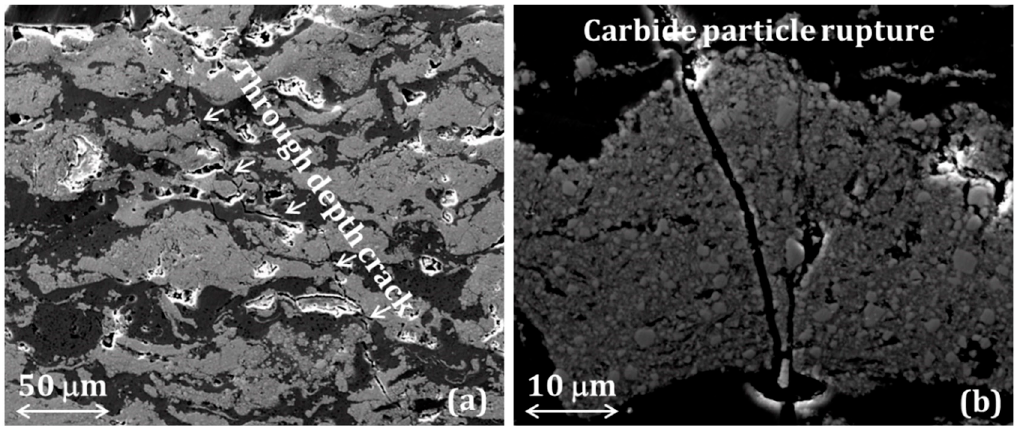
Figure 17. Degradation of a composite plasma-sprayed coating: ( a ) after tribological service a through-depth crack was developed below the contact area and ( b ) propagated through the carbide reinforcing particles resulting in their multi-rupture.